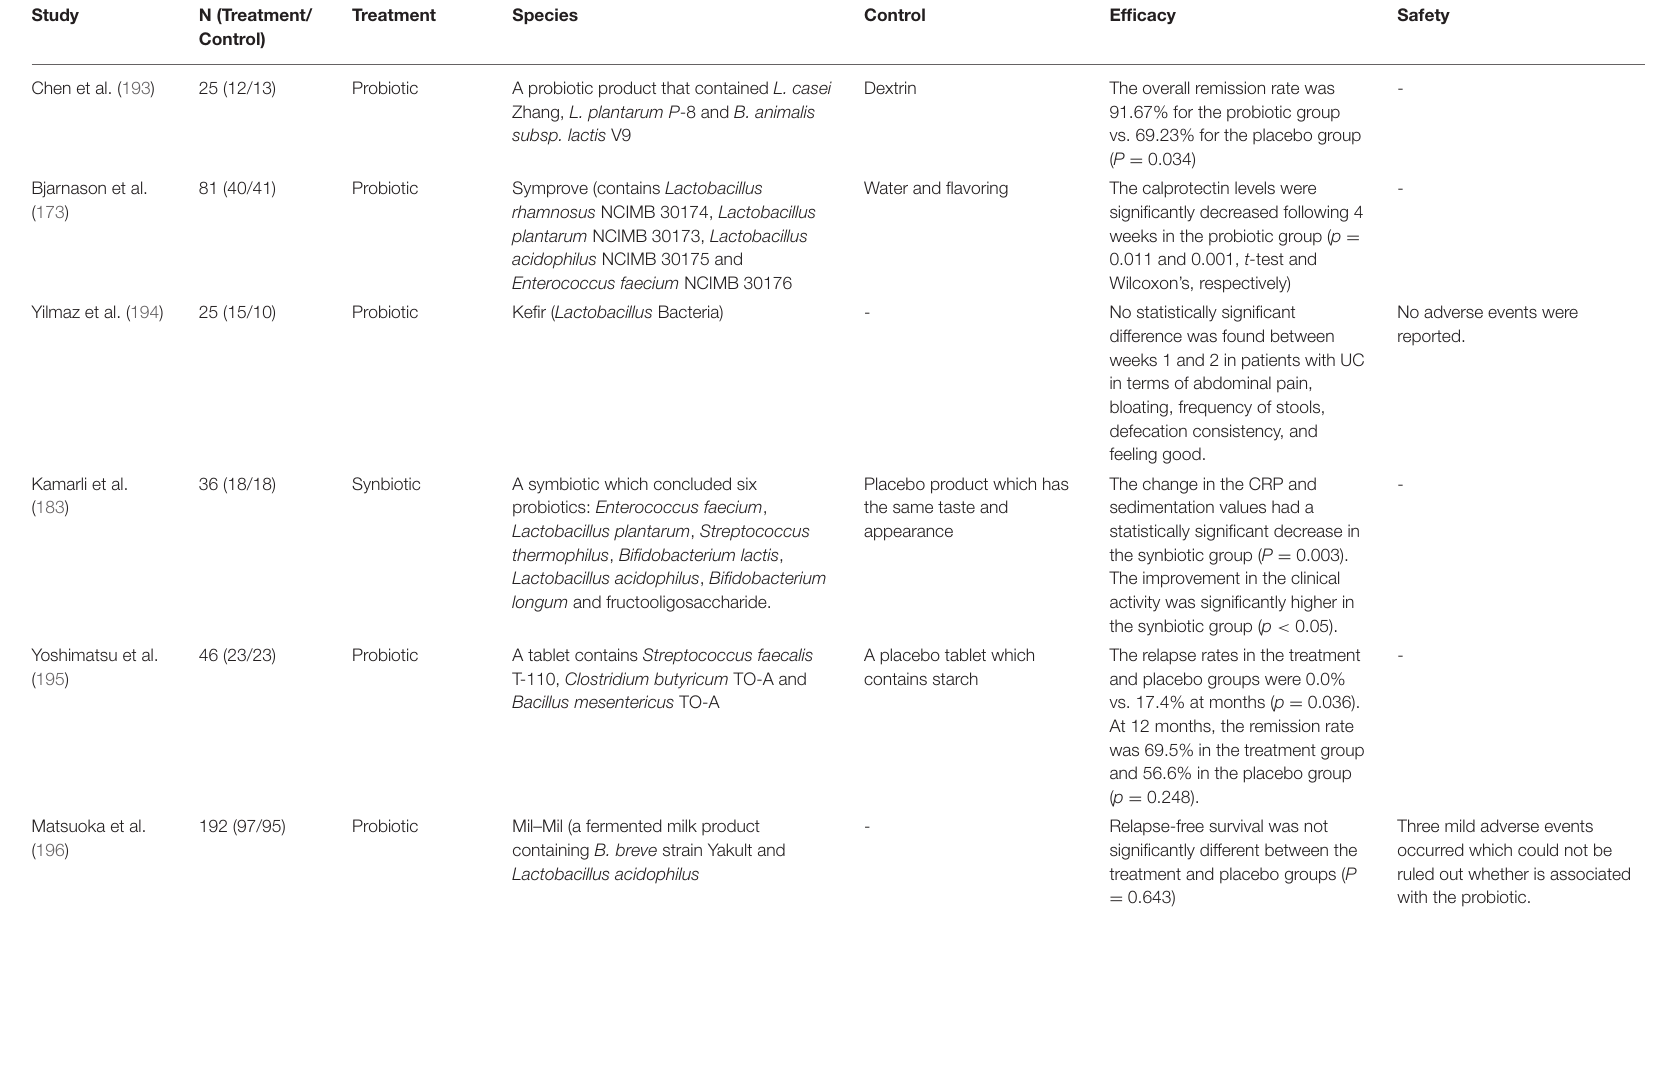
TABLE 4 | The characteristics of some clinical trials of probiotics, prebiotics and synbiotics for treating UC.